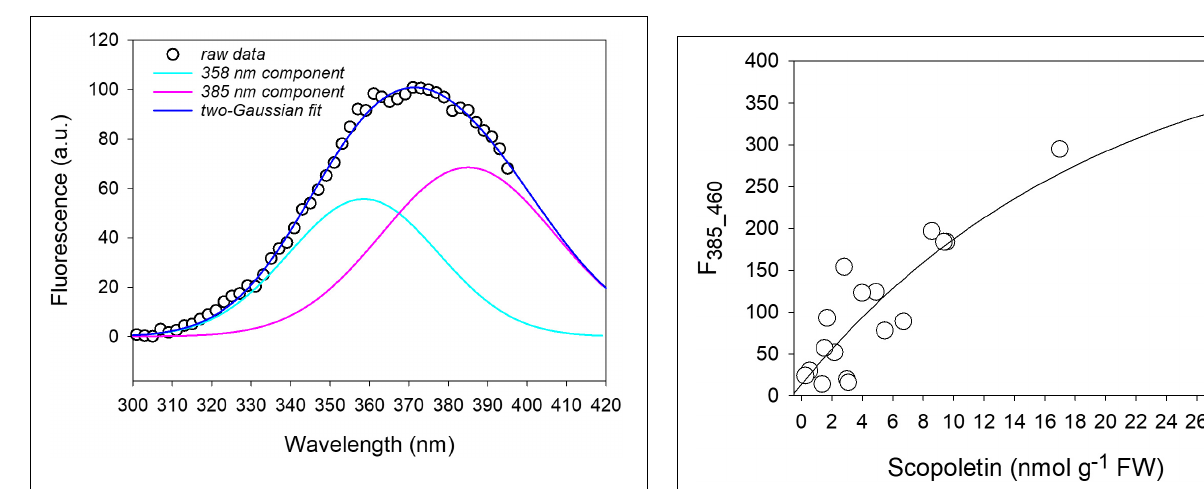
In Hevea brasiliensis , leaves inoculated with Phytophthora